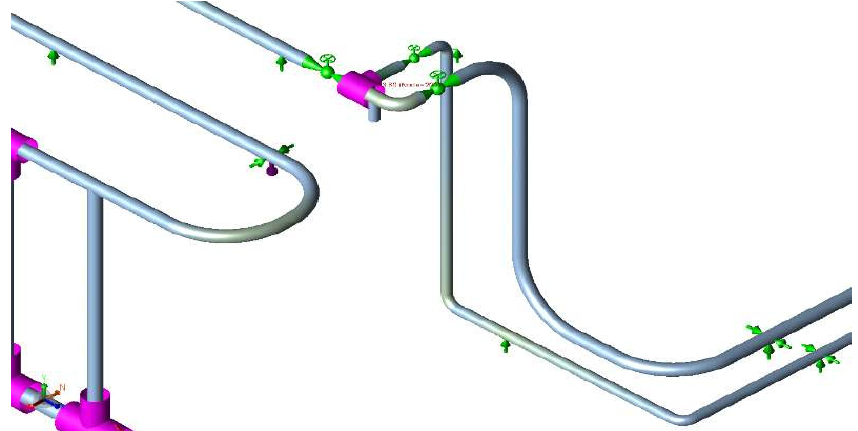
Figure 10. The location diagram of the maximum stress point.